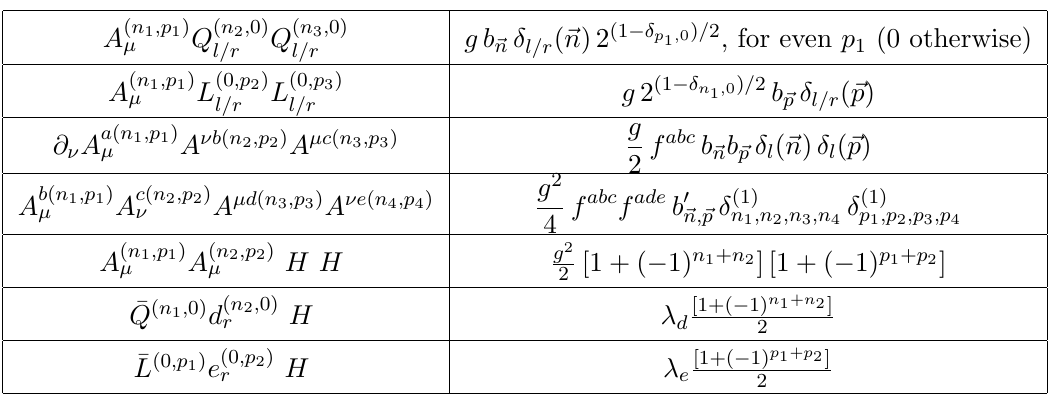
Table 2 . Interactions of bulk gauge boson (cid:12)elds, fermions and Higgs (cid:12)eld. f abc are the structure